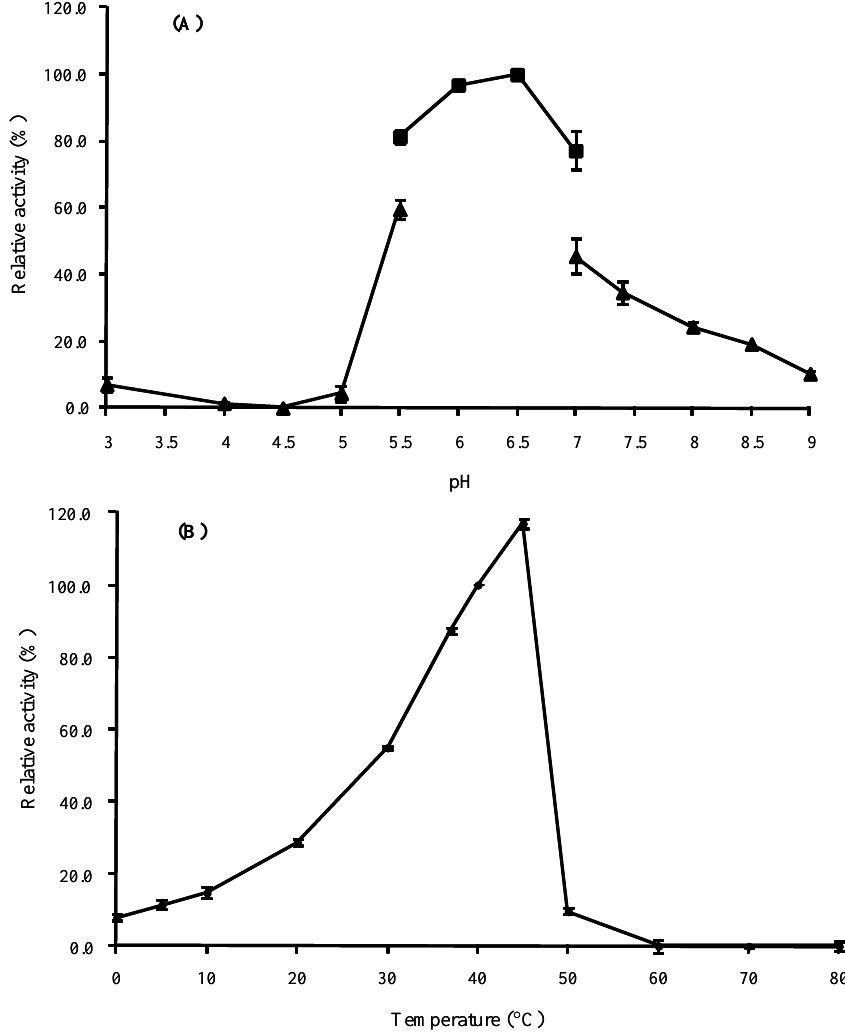
Figure 4. Optimal pH (A) and temperature (B) activity profiles. (A) Relative activity at 30  C and various pHs where 100% equates to 0.032  0.0011 U/ml. Used buffers : 50 mM glycine-HCl (pH 3) (closed triangle), 50 mM sodium acetate (pH 4 to 5.5) (closed triangle), 50 mM sodium phosphate (pH 5.5 to 7) (closed square), 50 mM Tris-HCl (pH 7 to 9) (closed triangle) (B) Relative activity at pH 6.5 and various temperatures where 100% equates to 0.035  0.0003 U/ml. The assays were performed at a final concentration of 1 mM p -Np-  - galactopyranoside. Data were expressed as mean and standard errors from three